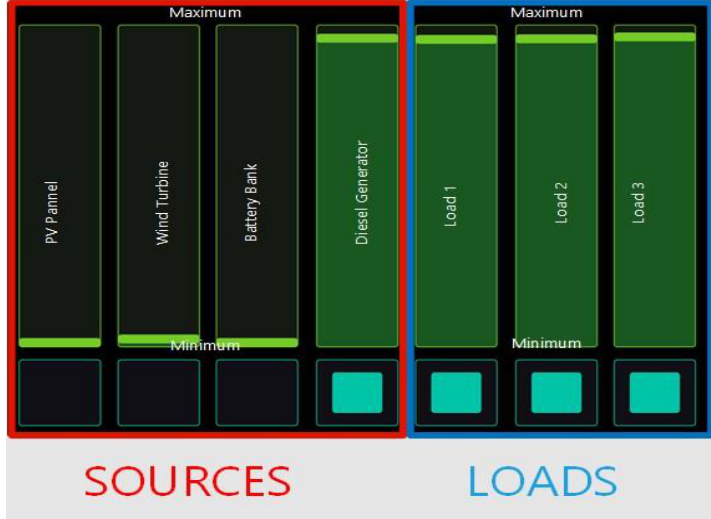
Figure 8. Monitoring Screen with DG ON and all loads ON